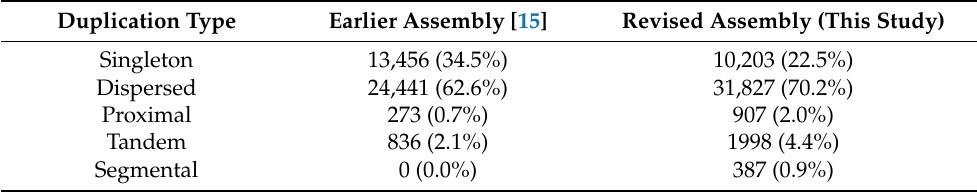
Table 2. Types of gene duplication identified in C. goreaui